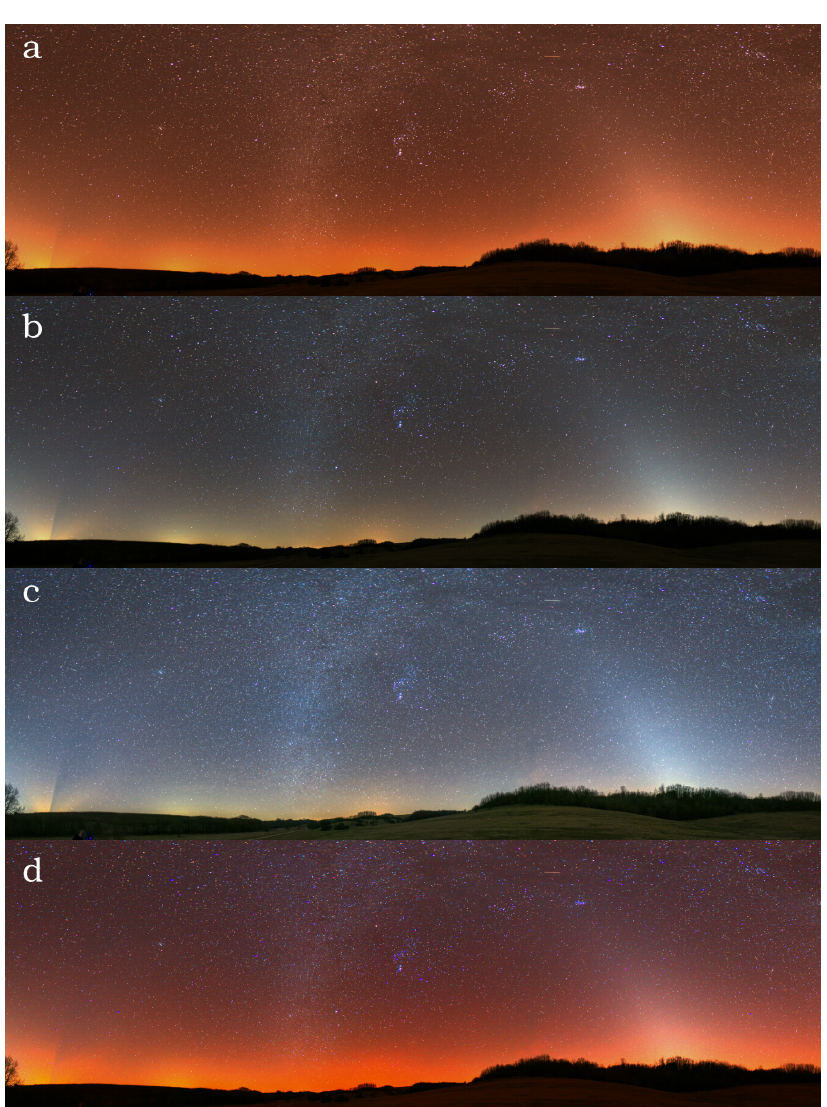
Figure 9. Different representations of the same photo taken at a moderately light polluted location at the Zselic Landscape Protection Area, Hungary. ( a ) real colours ( b ) 3800 K white balance setup, ( c ) manual additional processing, ( d ) false colour